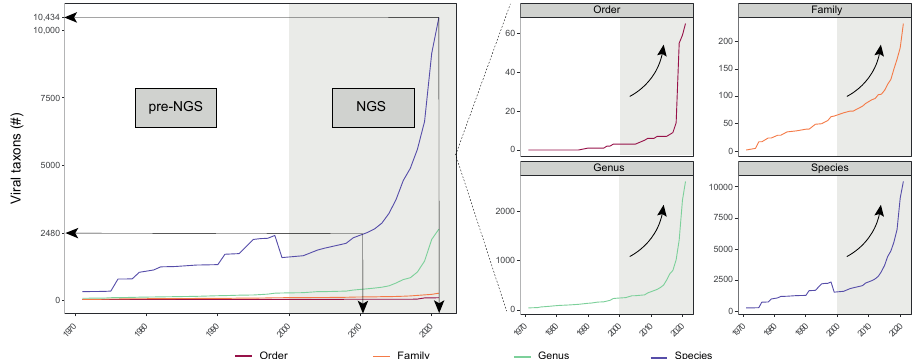
Figure 2. Expansion of viral taxa over time. Development of ICTV taxonomy across multiple taxonomical hierarchies (Order, Family, Genus, and Species) from the first public record in 1971 until 2021. The white and grey-colored area on the plot represents the viral taxonomies in the pre-NGS and NGS era, respectively. The arrival of NGS technology coincides with an exponential increase in viral taxa, especially in the last decade. For example, the number of viral species rose from 2480 to 10,434 between 2011 and 2021, which is more than a quadrupling of the known species in only one decade. Adapted from ref. [153].